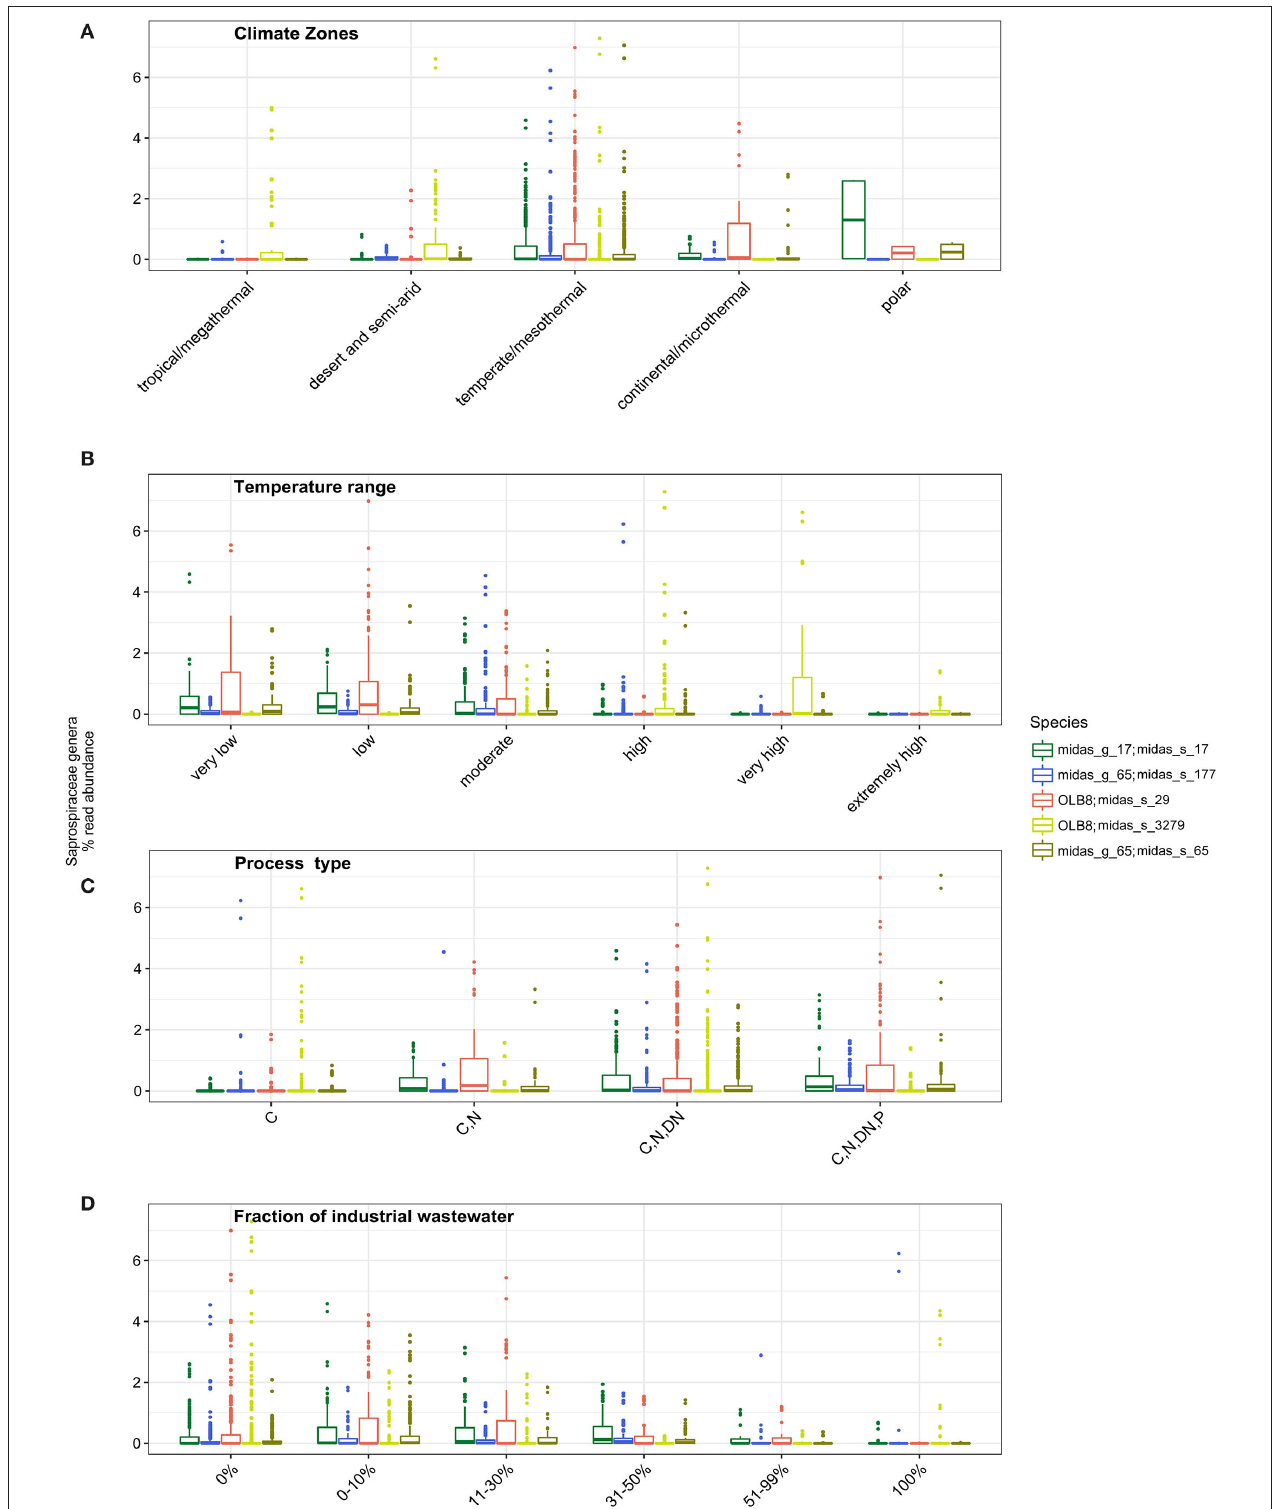
FIGURE 2 | Occurrence of different Saprospiraceae species across the world in relation to (A) different climate zone groupings (tropical/megathermal climate, 29 plants; dry (desert and semi-arid) climate, 48 plants; temperate/mesothermal climate, 368 plants; continental/microthermal climate, 24 plants; polar climate, 2